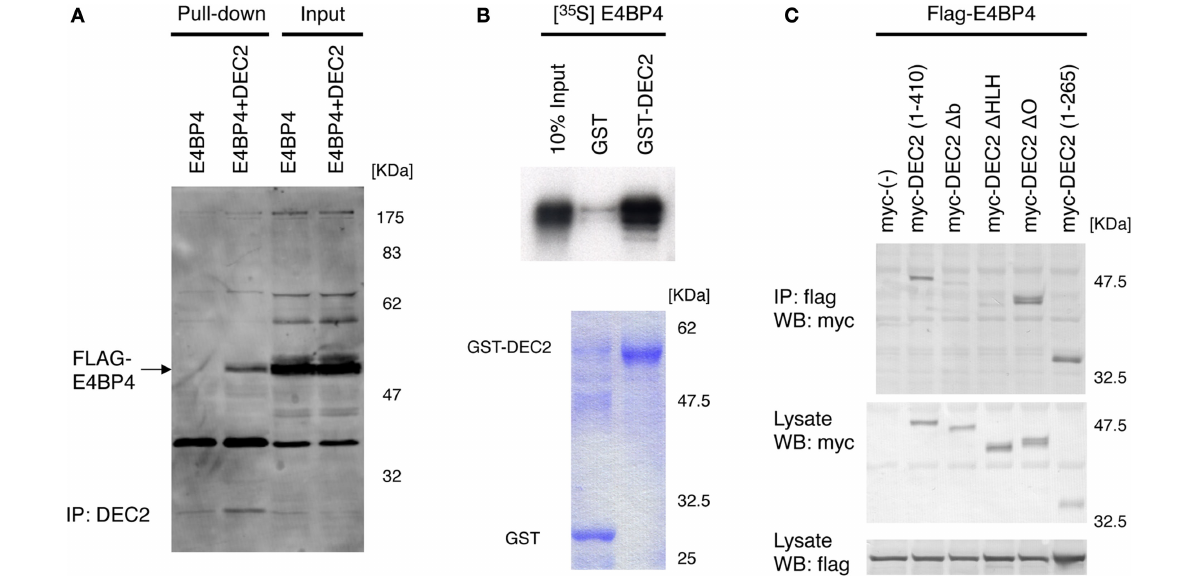
FIGURE 1 | DEC2 forms a heterodimer with E4BP4 . (A,B) Immunoprecipitation of E4BP4 and DEC2 complex. Flag-tagged E4BP4–DEC2 heterodimer was pulled down with anti-DEC2 antibody and protein A agarose beads. Flag-tagged E4BP4 protein was detected using immunoblotting with anti-FLAG antibody. Flag-tagged E4BP4–DEC2 heterodimer was detected in NIH3T3 cells co-expressing DEC2 and E4BP4 but not in the cells expressing E4BP4 only (A) . The data are a representative result of three independent experiments. Radioisotope labeled S 35 -E4BP4 was pulled down with GST-tagged DEC2 and glutathione-coupled agarose beads. The